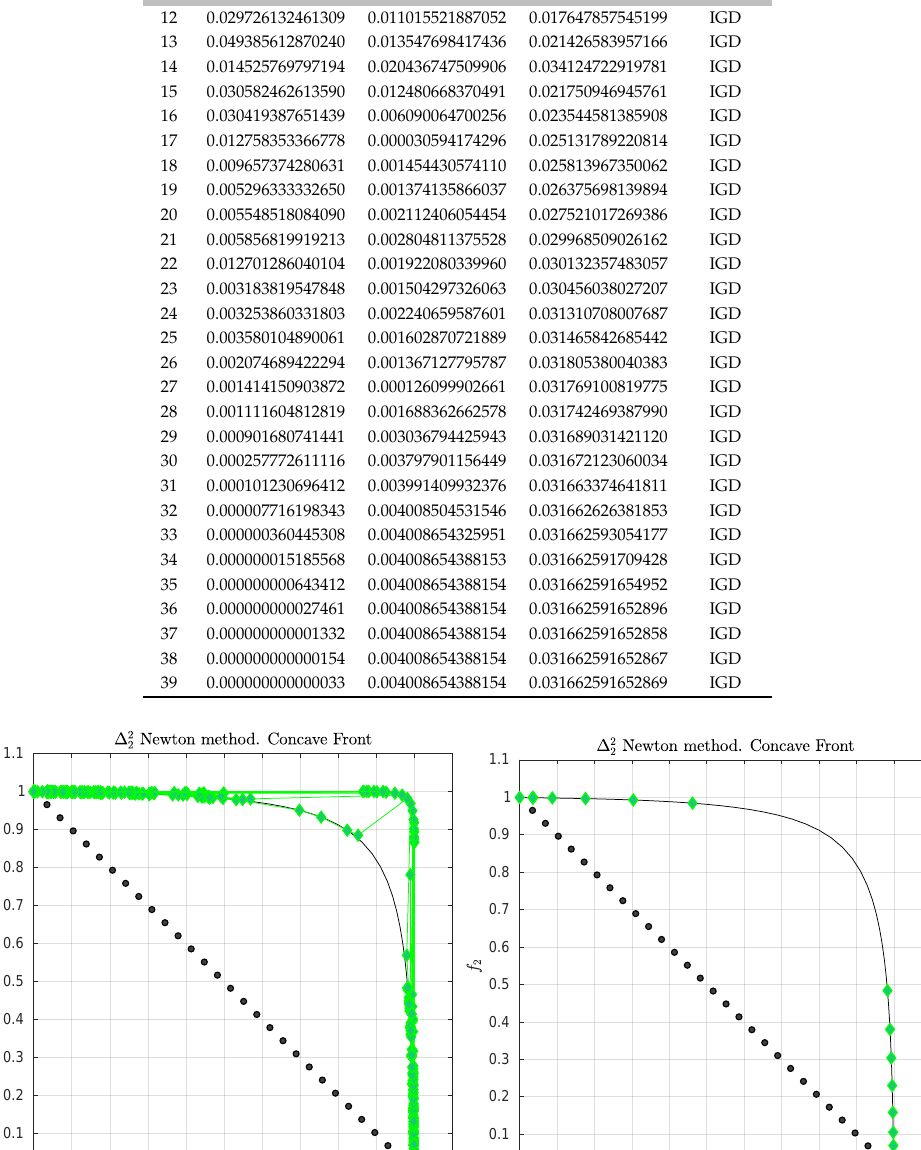
Table 6. Numerical results of the ∆ 2 Iter.